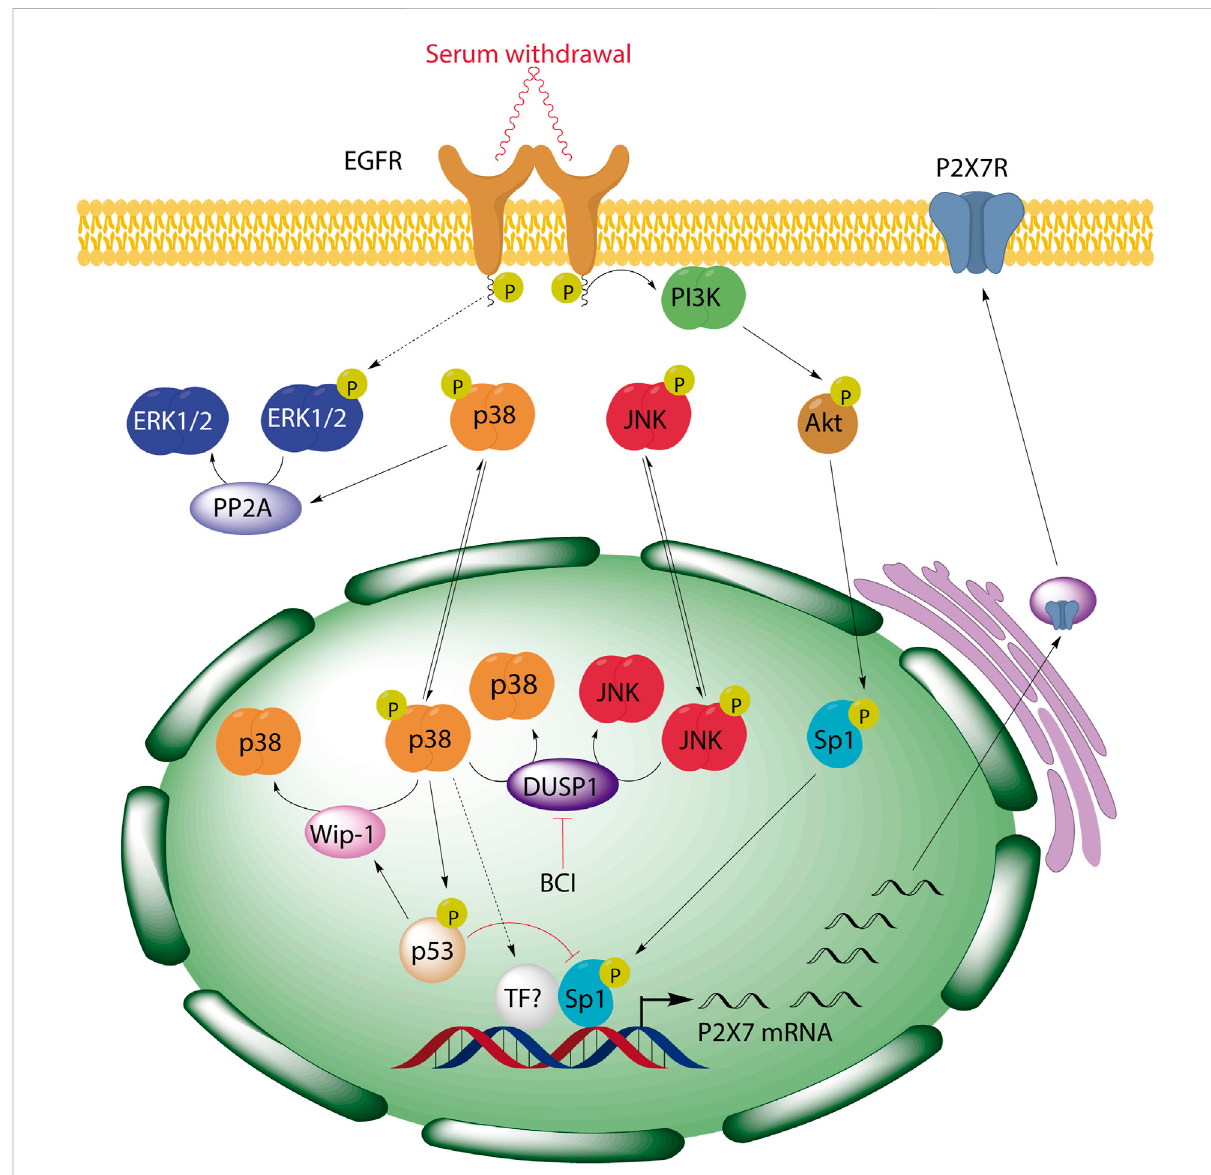
BCI-mediated inhibition of DUSP1 induces the upregulation of P2RX7 through the activation of p38 signaling pathway in neuroblastoma cells. We previously demonstrated that serum starvation triggers EGF-independent activation of EGFR and consequently, activation of PI3K/Akt pathway, resulting in Sp1 phosphorylation and the induction of P2rx7 gene expression. Here, we have described a negative regulatory loop between p38 and ERK1/2 MAPKs in neuroblastoma cells that involves p38-dependent activation of PP2A and PP2A-dependent dephosphorylation of ERK1/2. Moreover, inhibition of DUSP1 by BCI enhances P2rx7 gene expression through the activation of p38, which can also be modulated by its downstream target p53, and the participation of Sp1 transcription